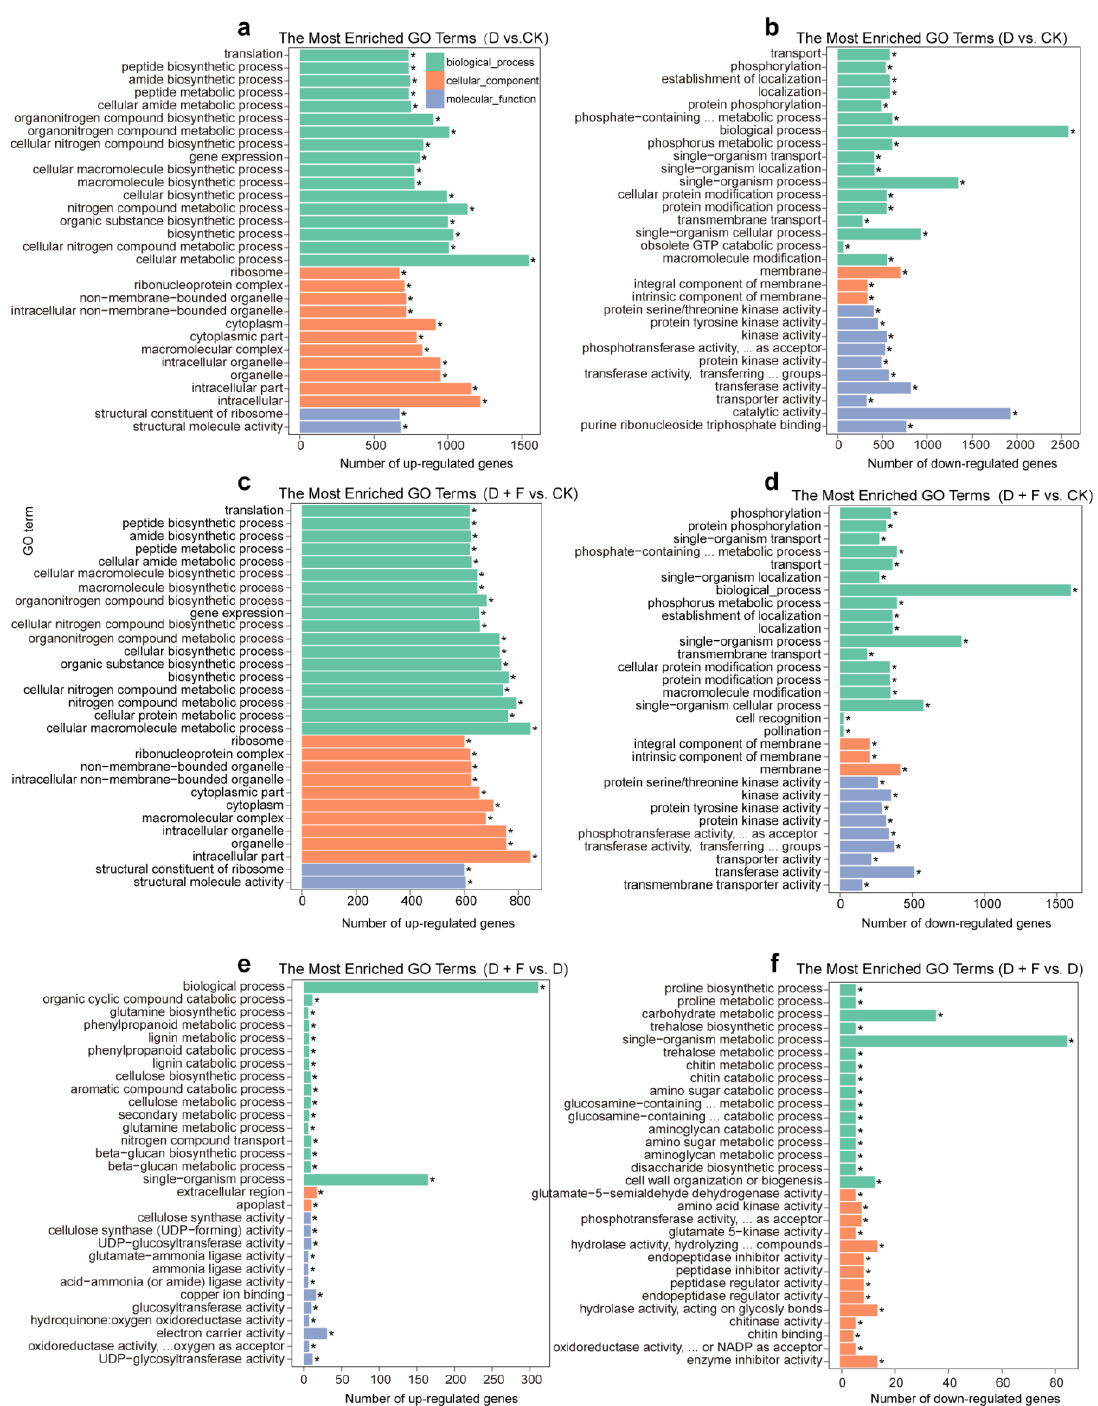
signal transduction” (Figure S1b).